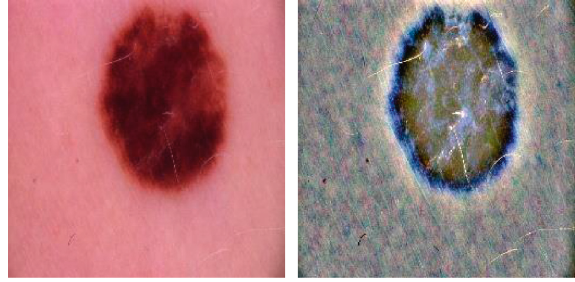
Figure 5: Before and after Gaussian function use.